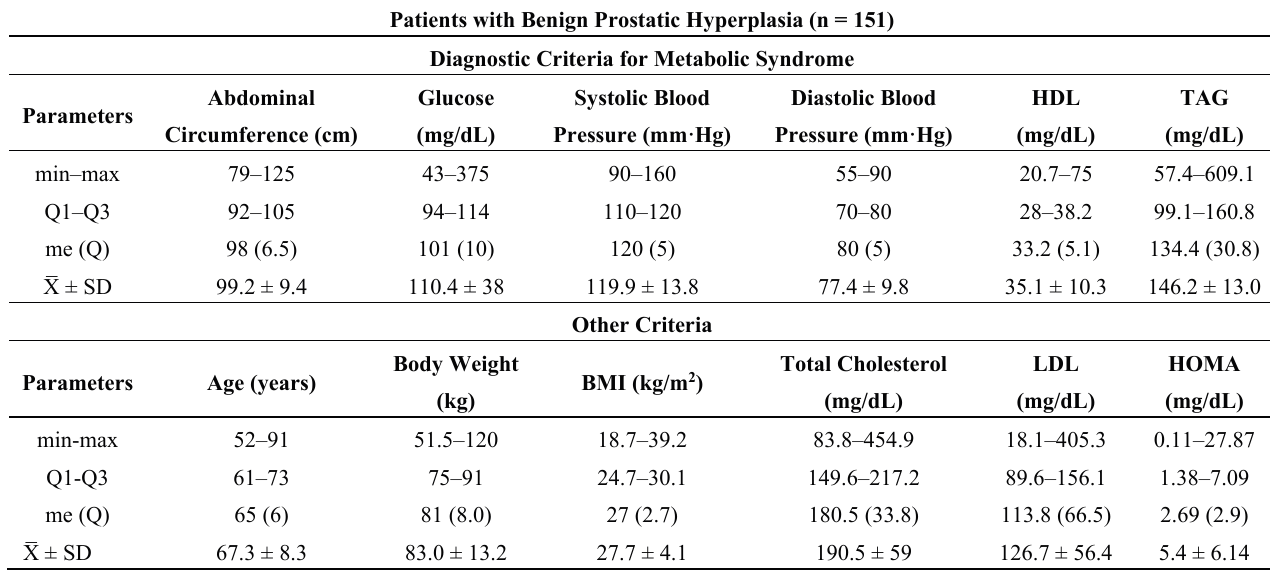
Table 2. Selected statistical parameters of the diagnostic criteria of metabolic syndrome and additional parameters in patients with benign prostatic hyperplasia.